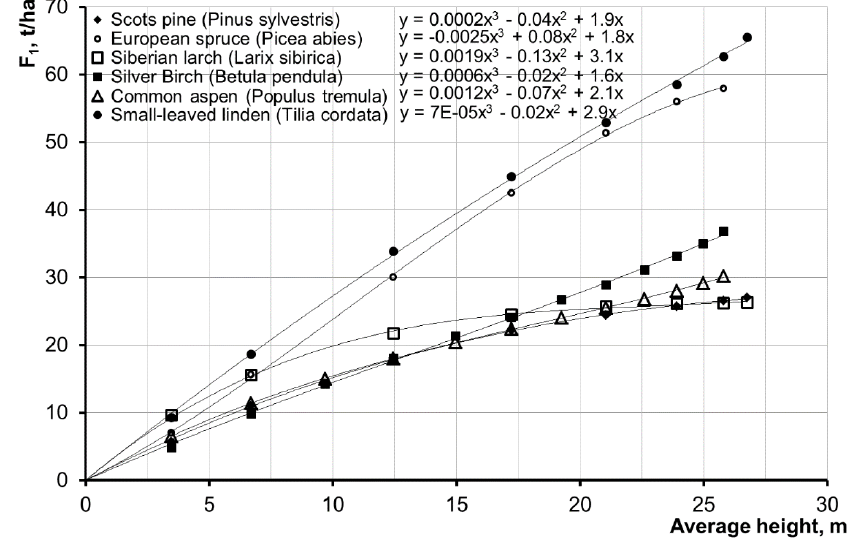
Figure 3. Dependency of phytomass on the average height (based on data from Shvidenko A.Z., Shchepashchenko D.G., Nil’sson S. & Buluy YU.I. [11]).